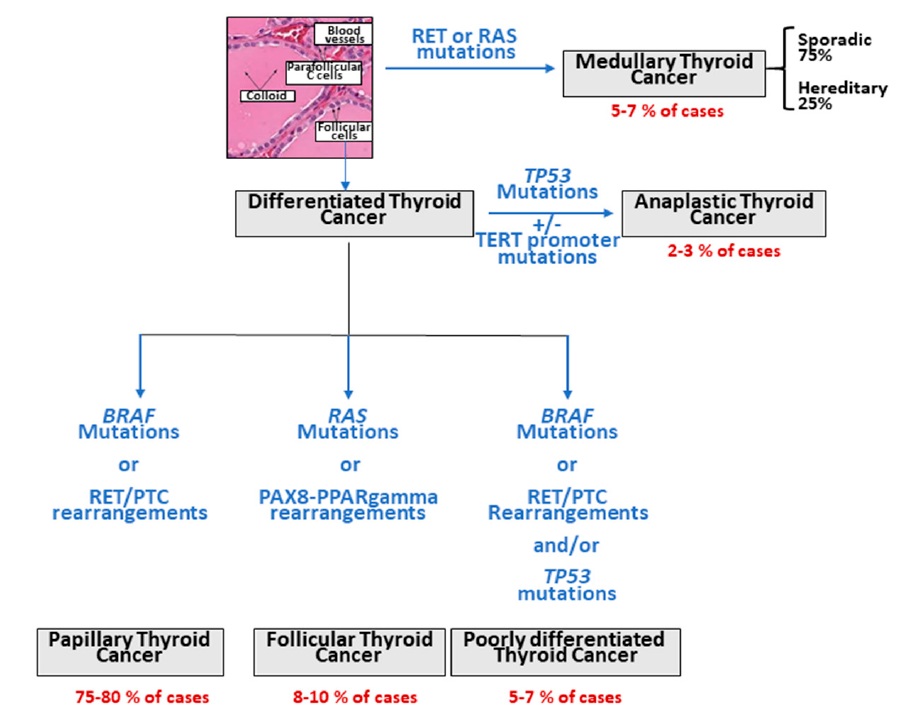
Figure 1. Different histological types of thyroid carcinomas and most relevant/driver molecular alterations.